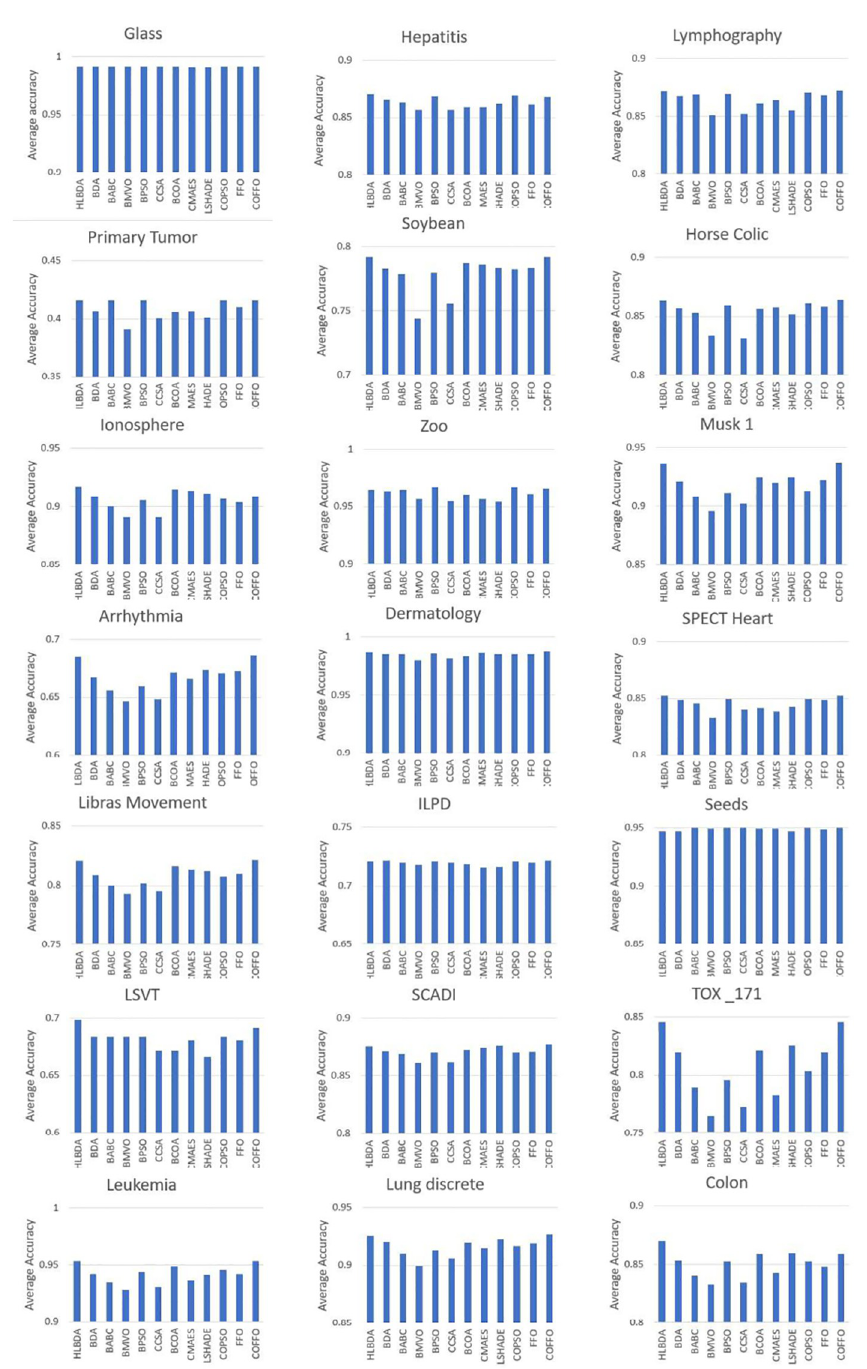
Fig 2. The result of the accuracy of tested